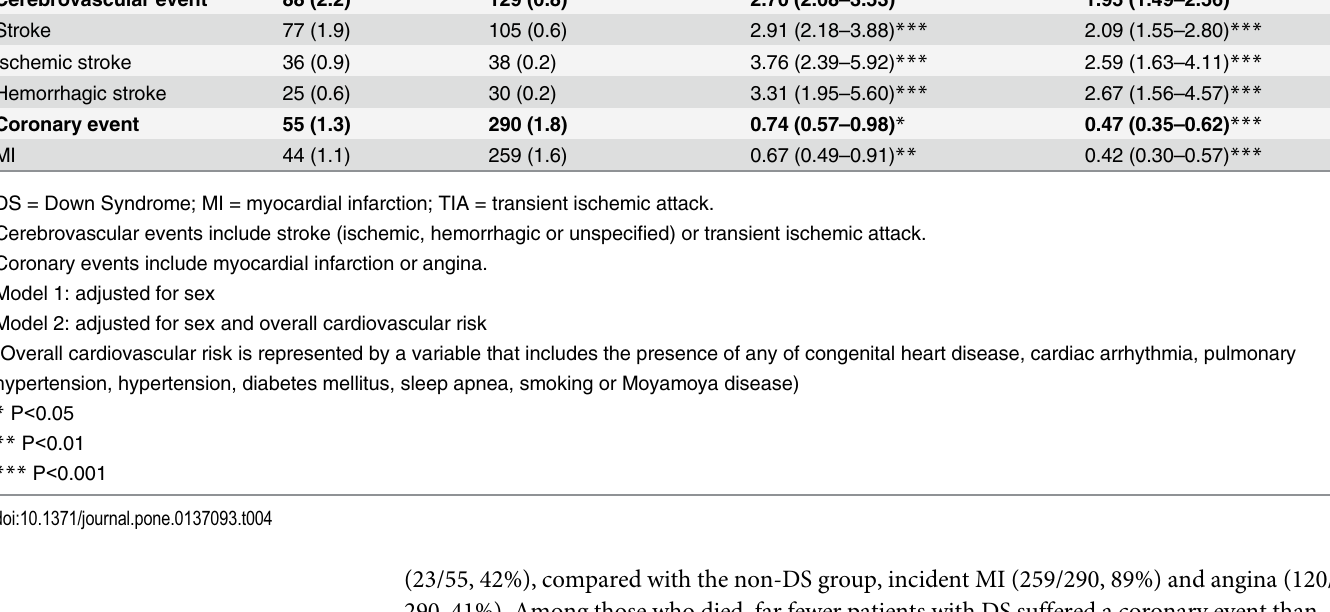
Table 4. Risk of cardiovascular events in patients with Down Syndrome. (Data are n [%] patients unless otherwise indicated). DS (n =